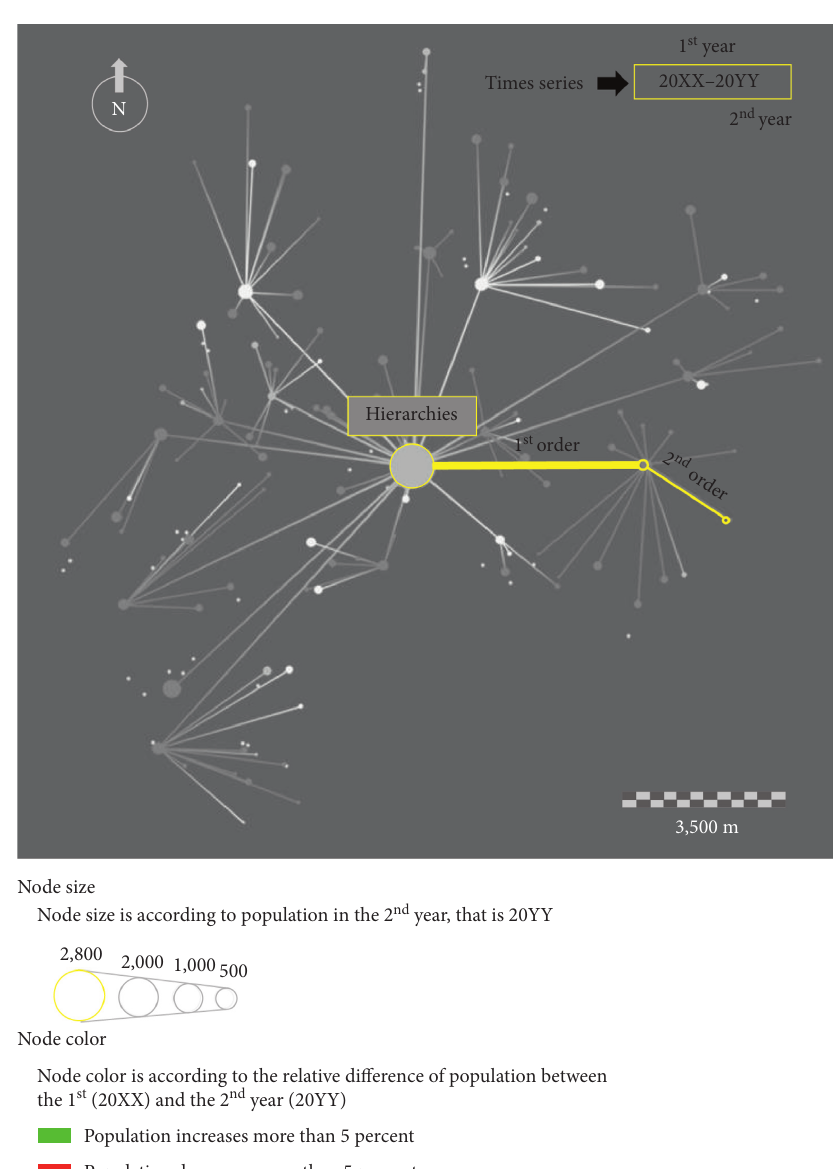
Figure 3: Methodology for mapping population dynamics using spatial networks. This methodology is applied in Section